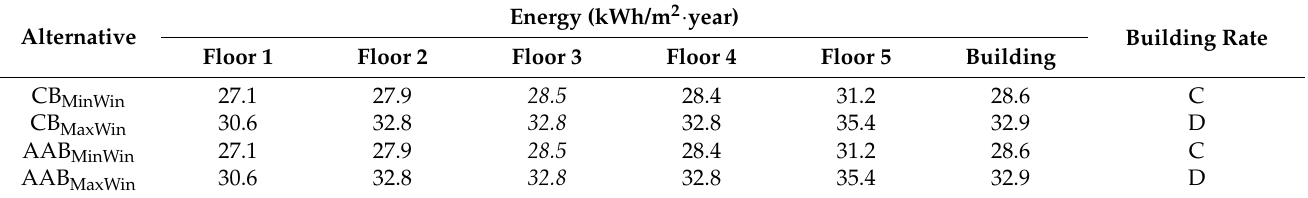
Table 4. Office-type building: energy assessment and building rates.